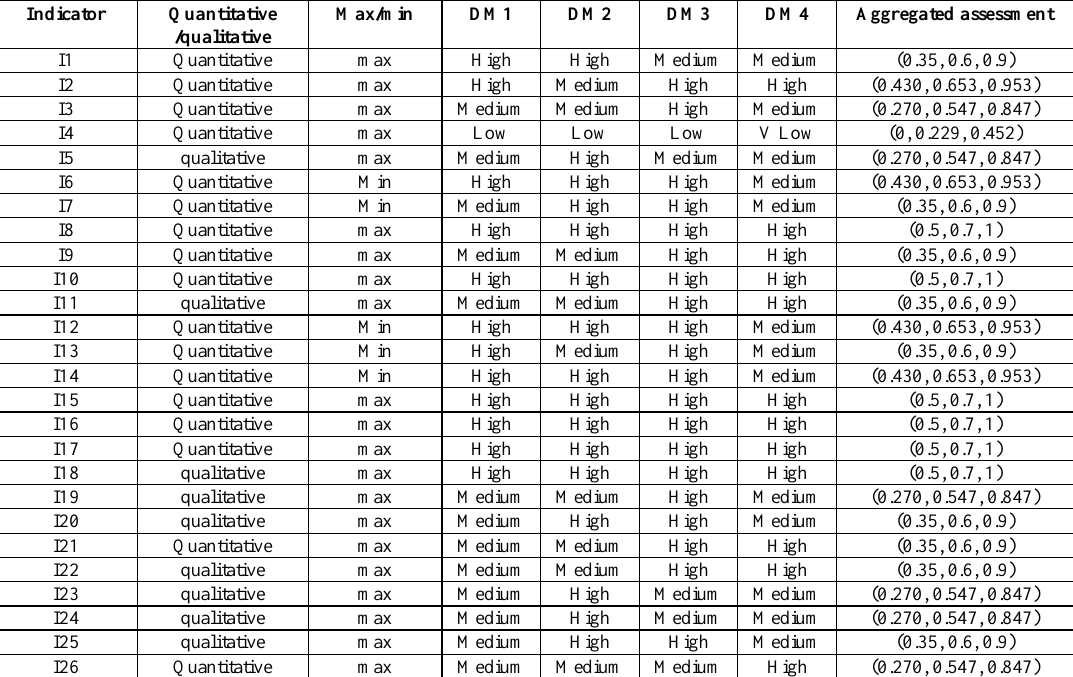
Table 2. Indicators individual evaluations, nature and collective assessments